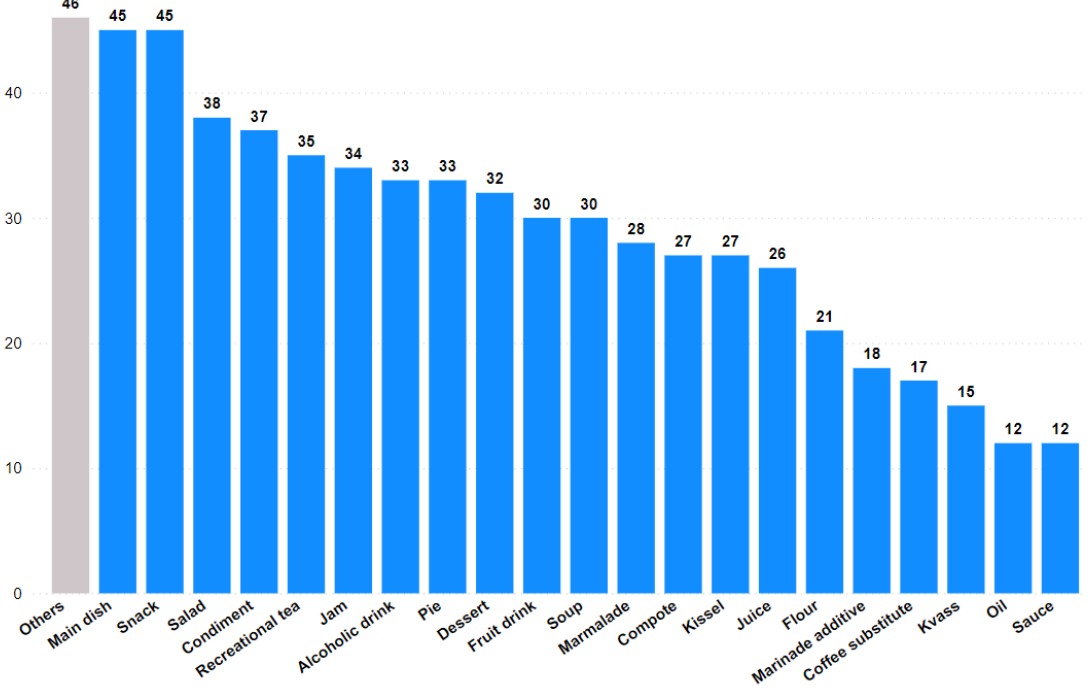
Figure 5. The most frequently proposed modes of food use in terms of the number of plant